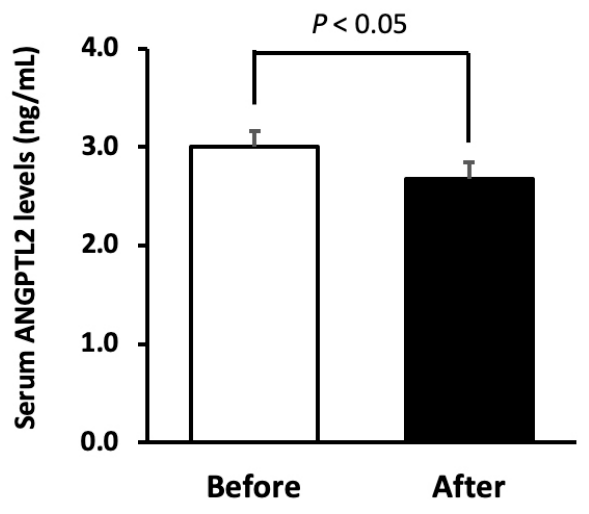
Fig. 1. Serum ANGPTL2 levels before and after a 12-week aerobic exercise training. Data are presented means ± SD.